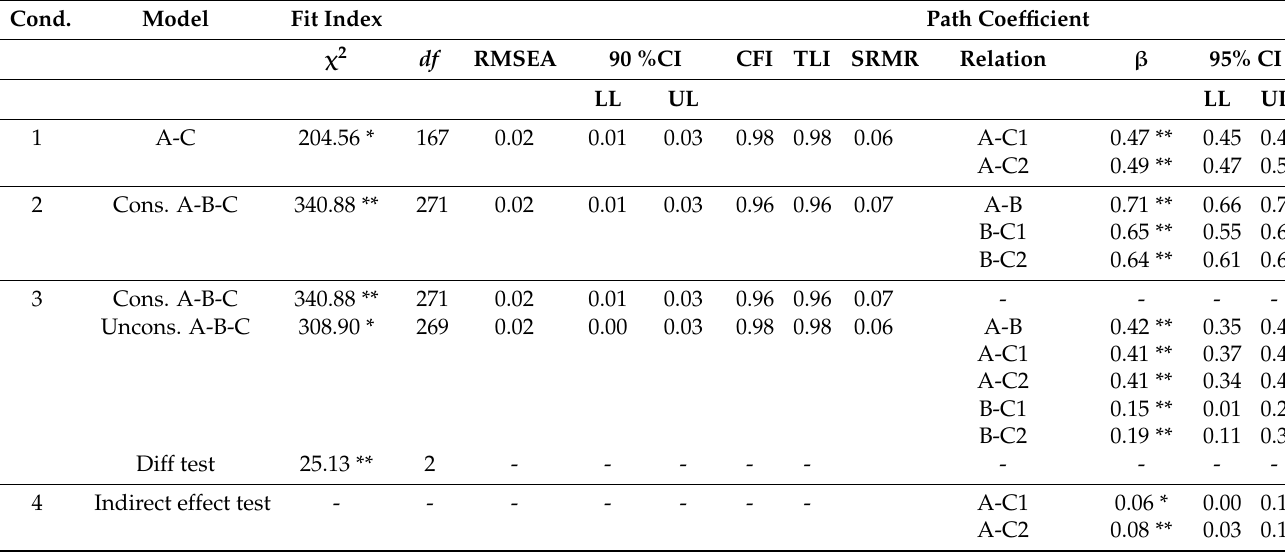
Table 4. Fit indices and path coefficients for the mediation model for boys.